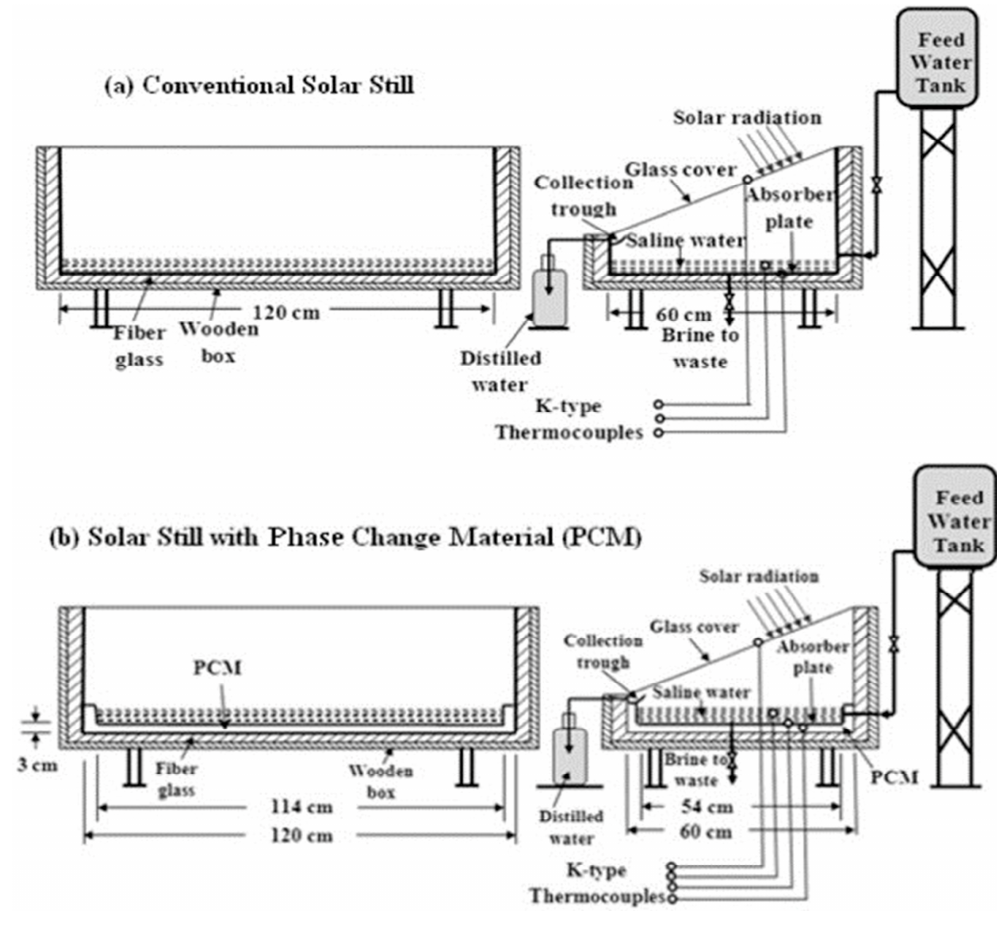
Figure 9. Solar still with and without PCM [101], reused with permission from Elsevier (license number 5491440494608).